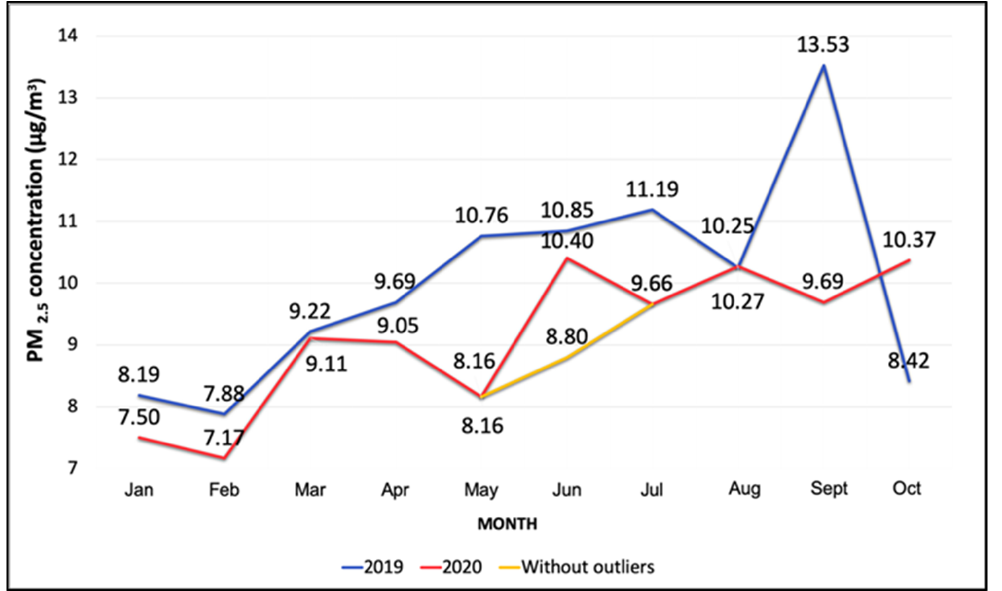
Figure 3. Variation in monthly mean PM 2.5 concentrations (µg/m 3 ) from January to October in 2019 and 2020. The mean concentration in June is shown with and without the outlier due to a dust storm.